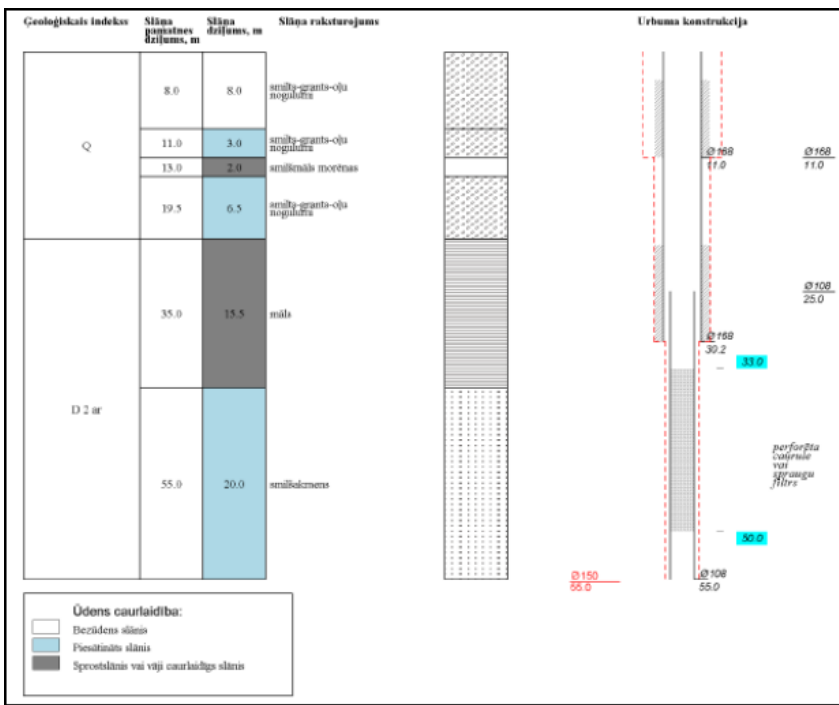
Figure A2: Example of the information obtained from the wells in the LEGMC